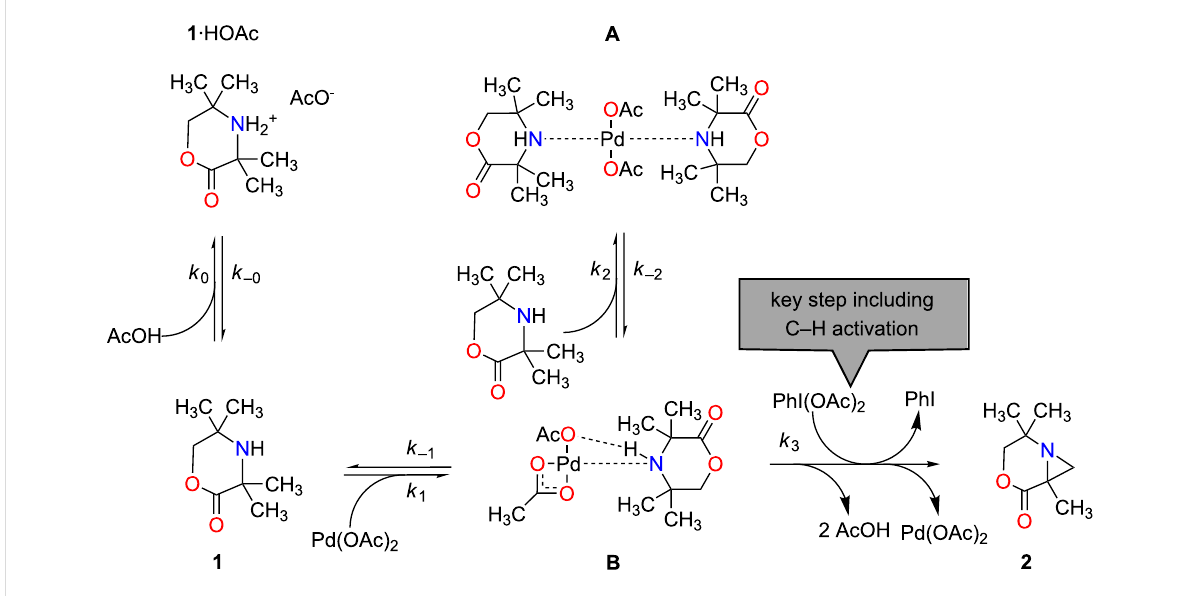
A priori knowledge Source reaction mechanism, concentration constraints of species due to degradation of starting material and product. Gibbs free energies of reaction, obtained from DFT study. target values based on best results from previous experimental study. physical constraints (maximum oxidant concentration to prevent crystallisation, maximum temperature to prevent excessive catalyst